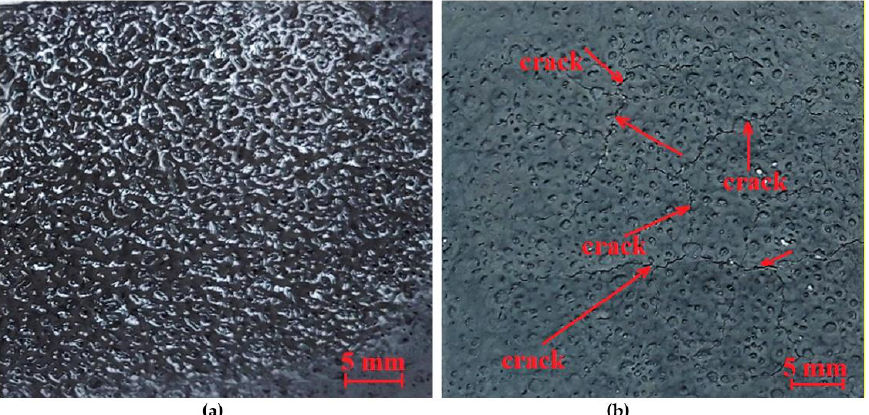
Figure 4. Foamed geopolymer layer sprayed on an aluminum foil: ( a ) foaming effect after partial drying, ( b ) foaming effect after complete drying with visible cracks.